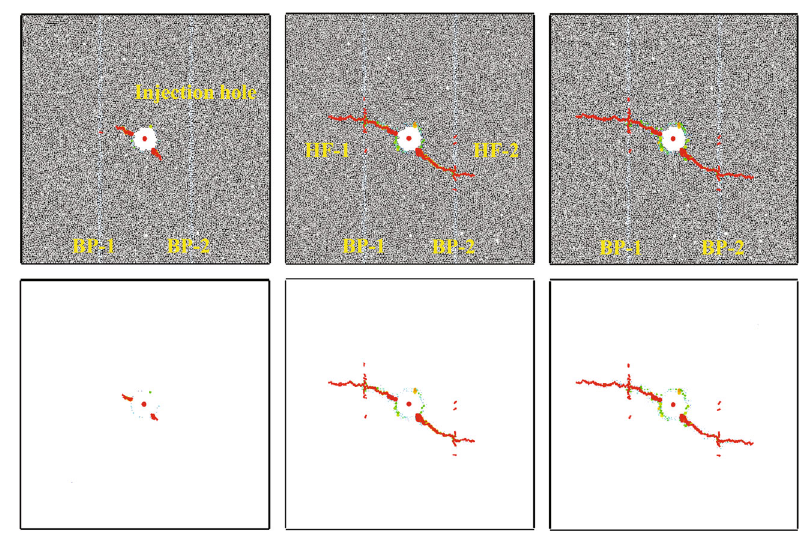
Figure 13: Group 2-1 hydraulic fracture morphology and interactive penetration mode.